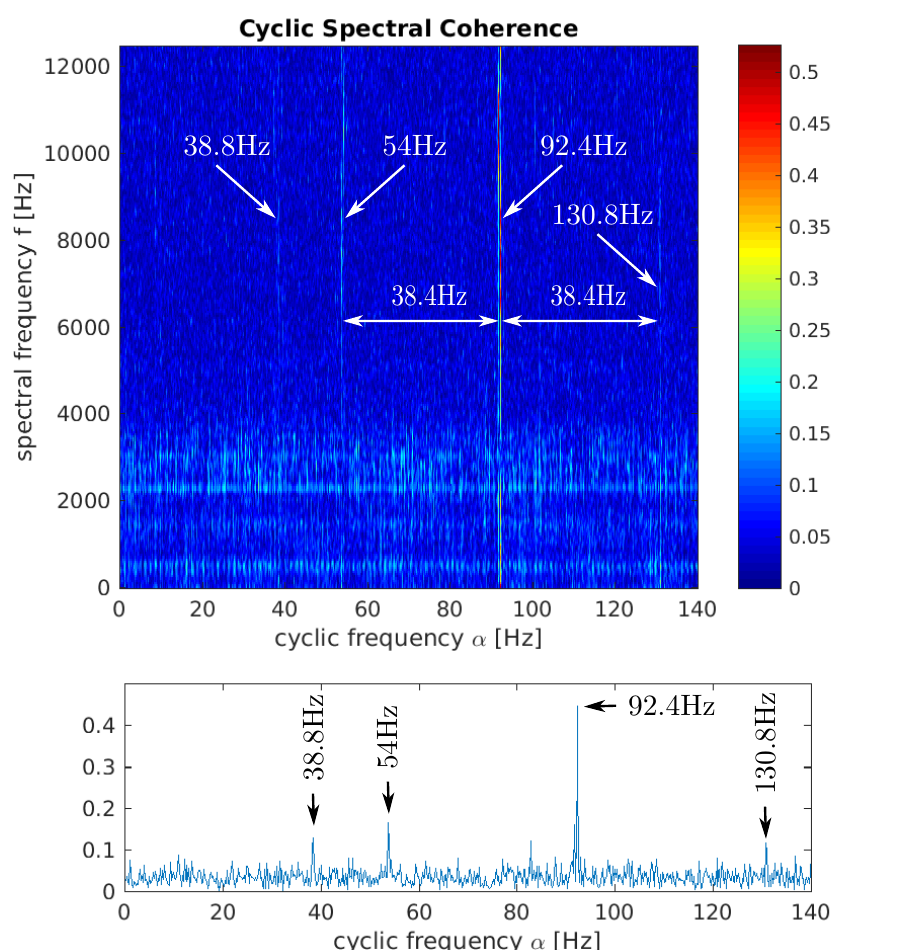
Figure 6. Cyclic Spectral Coherence of the first bearing; top figure shows the BPFO frequency (92.4